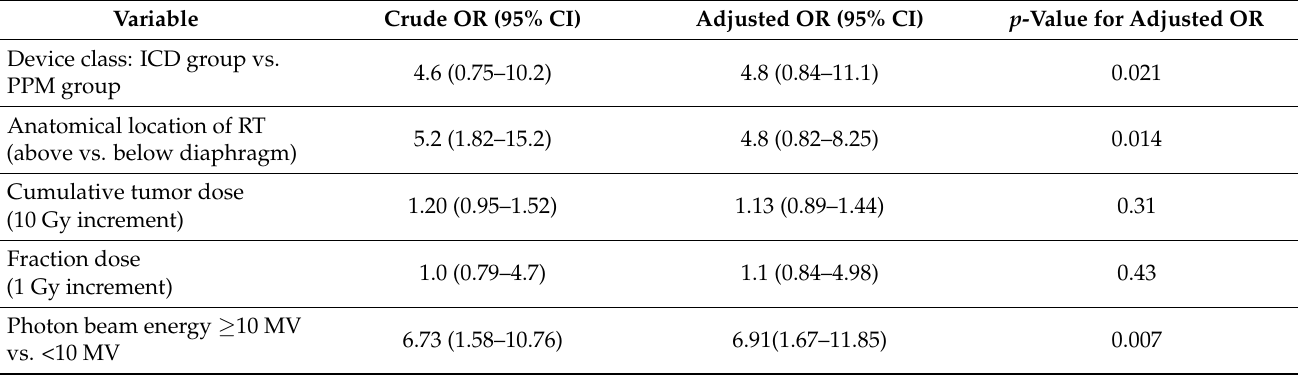
Table 3. Crude and adjusted logistic regression analysis of factors associated with CIED malfunctions with RT ( n = 441). PPM group consists of SC PPM, DC PPM, and CRT–P. The ICD group consists of ICD and CRT–D. The anatomical location of RT above the diaphragm consists of the head and neck, thorax, and upper limb. The anatomical location of RT below the diaphragm consists of the abdomen and pelvis, spine, and lower extremities. CIED, cardiac implantable electronic device; CRT–P, cardiac resynchronization therapy pacemaker; CRT–D; cardiac resynchronization therapy defibrillator; DC PPM, dual chamber permanent pacemaker; Gy, gray, ICD, implantable cardioverter defibrillator; MV,